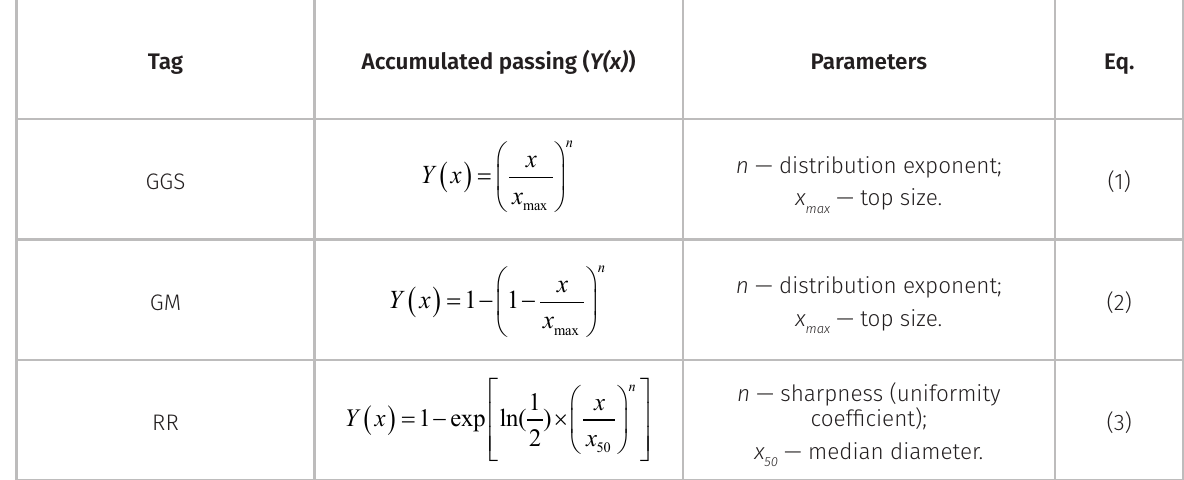
Tag Accumulated passing ( Y(x) ) Parameters